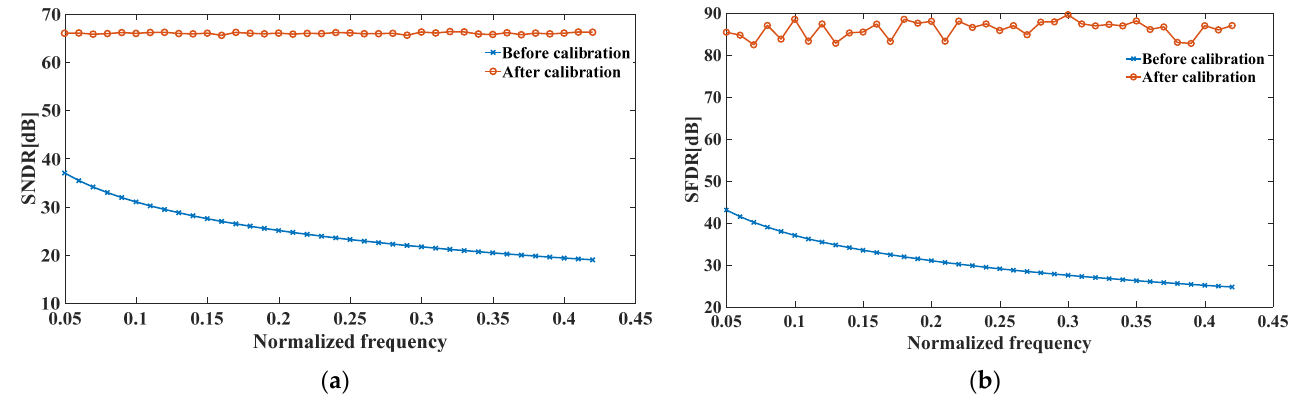
Figure 6. Performances of bandwidth mismatch calibration with the proposed method. ( a ) The SNDR of TI-ADCs with different frequencies; ( b ) the SFDR of TI-ADC with different frequencies.